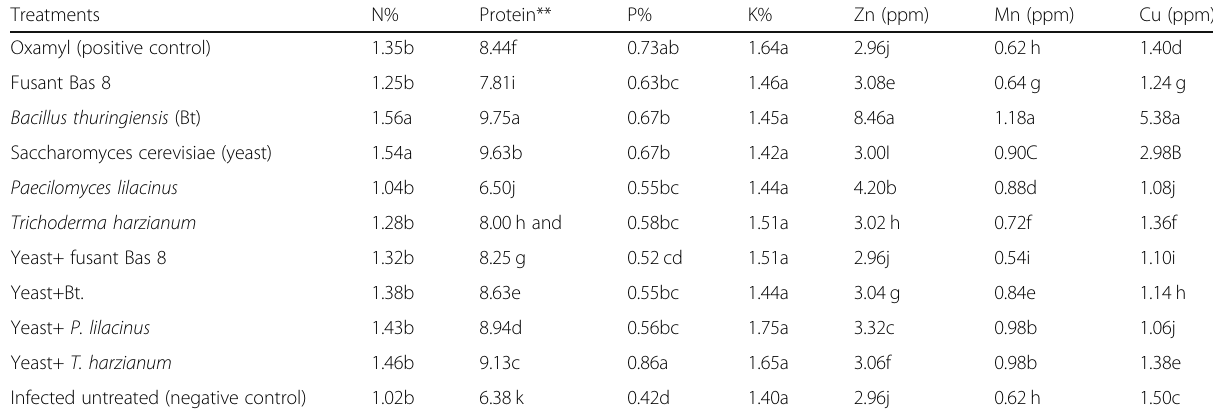
Table 5 Protein content, macro and micronutrients in peanut seeds in response to fusant Bas 8, Bacillus thuringiensis Bt, Saccharomyces cerevisiae , Paecilomyces lilacinus , and Trichoderma harzianum applications of peanut plants infected by M. javanica